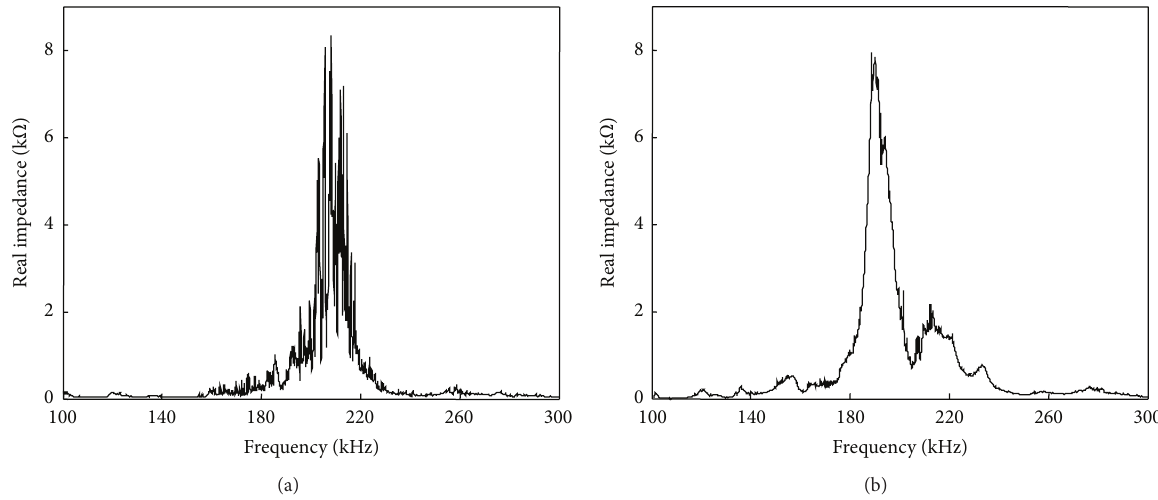
Figure 3: Real impedance spectra in the range of 100–300 kHz measured from (a) joint A and (b) joint B under health states.